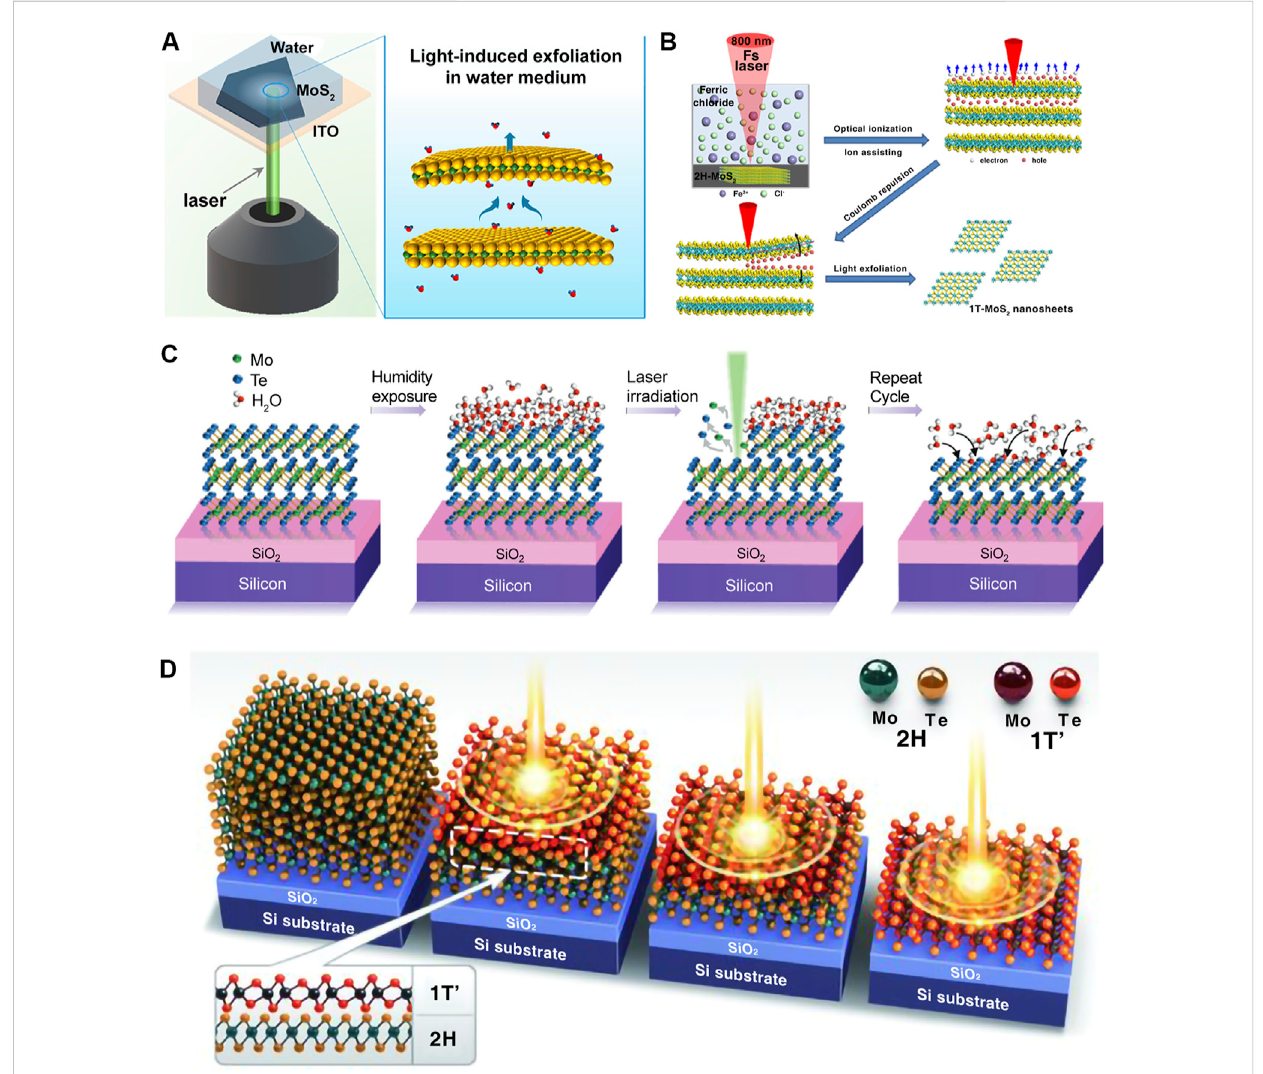
FIGURE 1 Top-down synthesis methods. (A) Schematicof thelaser exfoliation device for 2H-MoS 2 fl akes in aqueous media (Zhai etal., 2021)(Copyright2021, American Chemical Society). (B) Schematic of the preparation of MoS 2 nanosheets through femtosecond laser exfoliation (Zuo et al., 2021) (Copyright 2021,AmericanChemicalSociety). (C) SchematicofthemechanismforlaserthinningofMoTe 2 (Nagareddyetal.,2018)(Copyright2018,Wiley-VCH). (D) Schematic of the laser-driven phase patterning process of MoTe 2 from 2H to 1T ′ (Cho et al., 2015) (Copyright 2015, American Association for the Advancement of